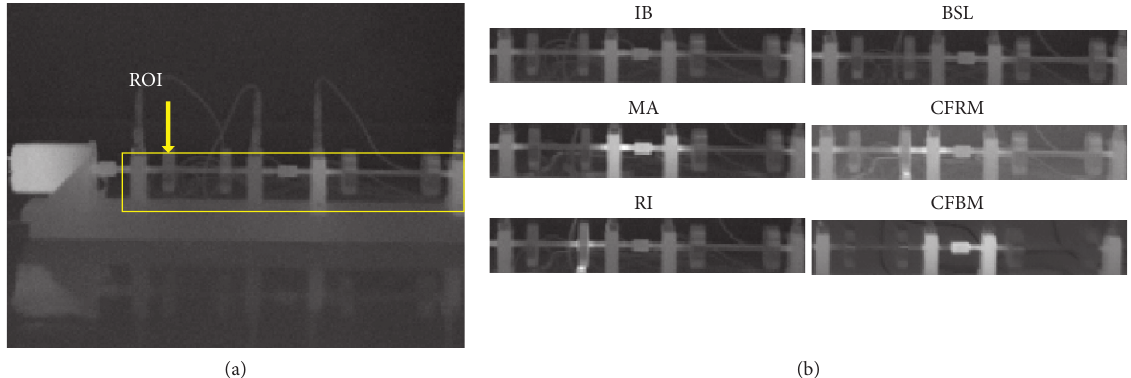
Figure 8: Comparison of infrared images in different states., (a) Infrared Image and ROI in the normal state. (b) ROIs at different conditions